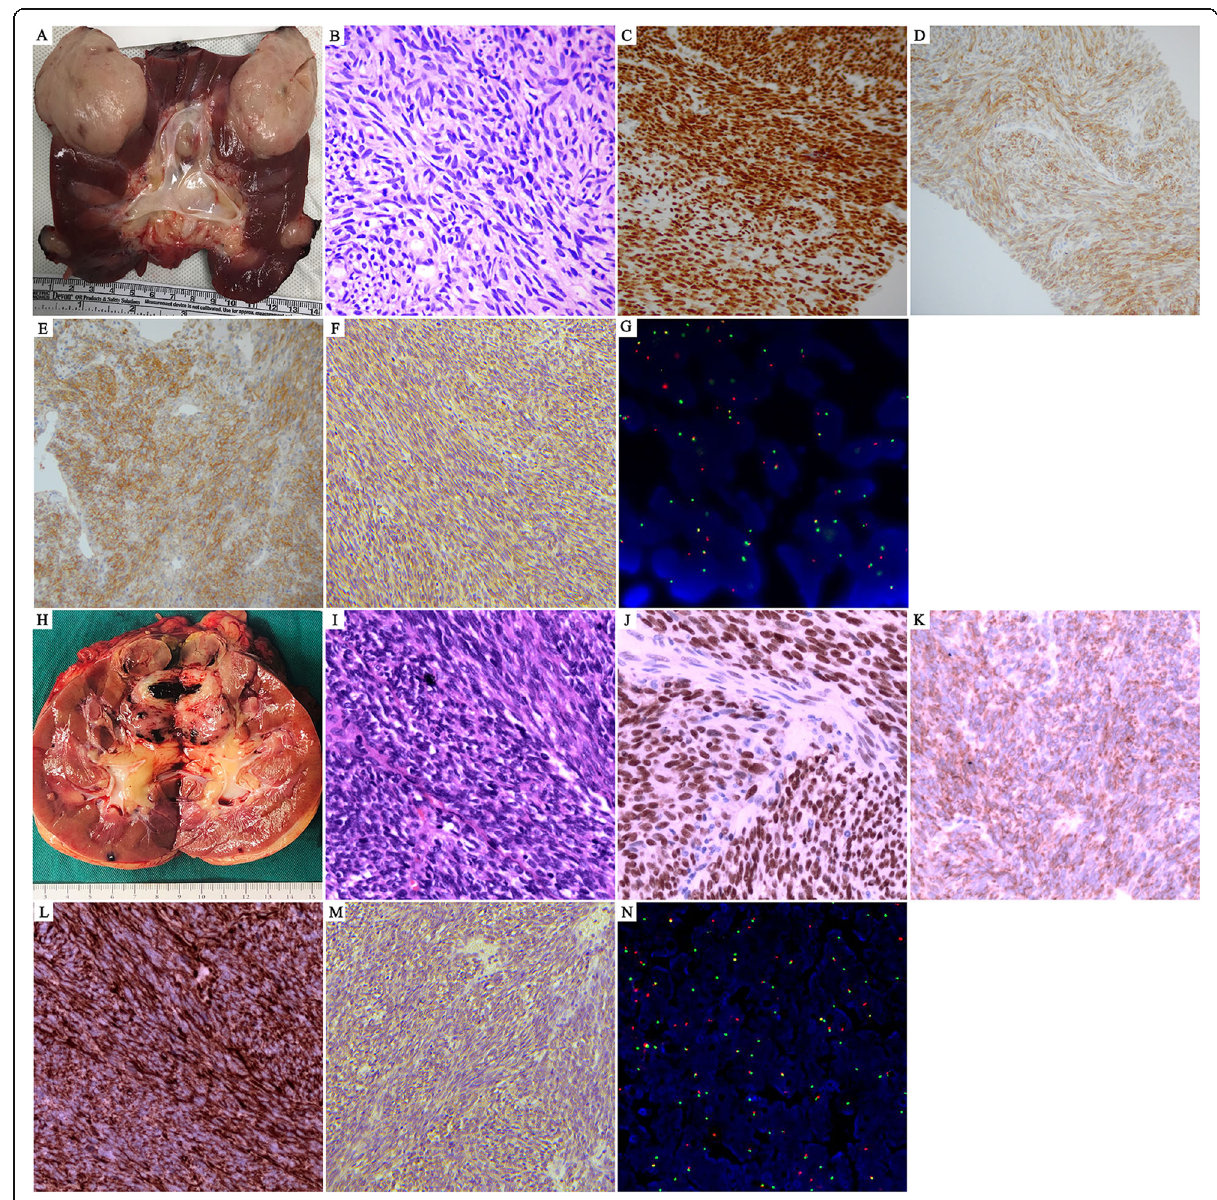
Fig. 3 Histopathology of allograft synovial sarcoma. Recipient 2: A : specimen; B : H&E staining (200×); C : TLE1 (100×); D : Bcl-2 (100×); E : CD99 (200×); F : STAT6; G : FISH test; Recipient 3: H : specimen; I : H&E staining (200×); J : TLE1 (200×); K : Bcl-2 (200×); L : Vimentin (200×); M : STAT6; N : FISH